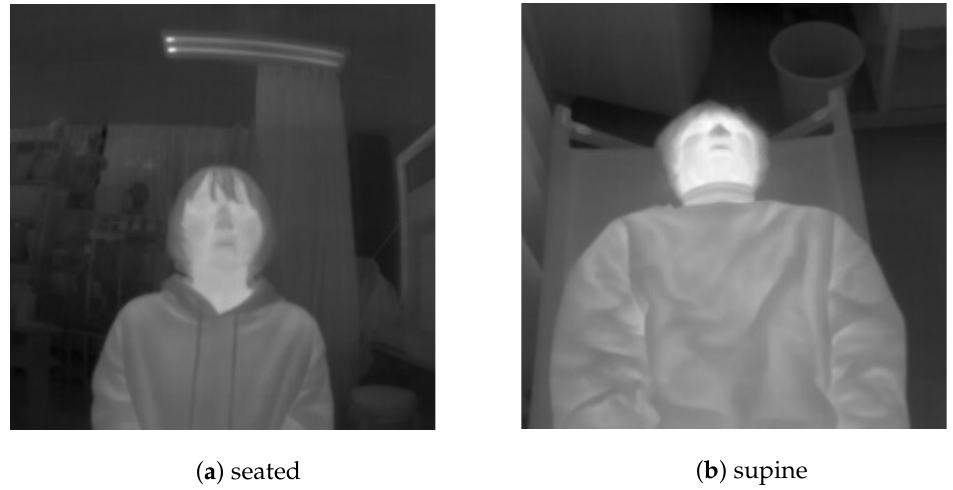
Figure 6. Training data: Images obtained from the thermal imaging camera for YOLOv3 training. The images were taken in a seated ( a ) and supine ( b )